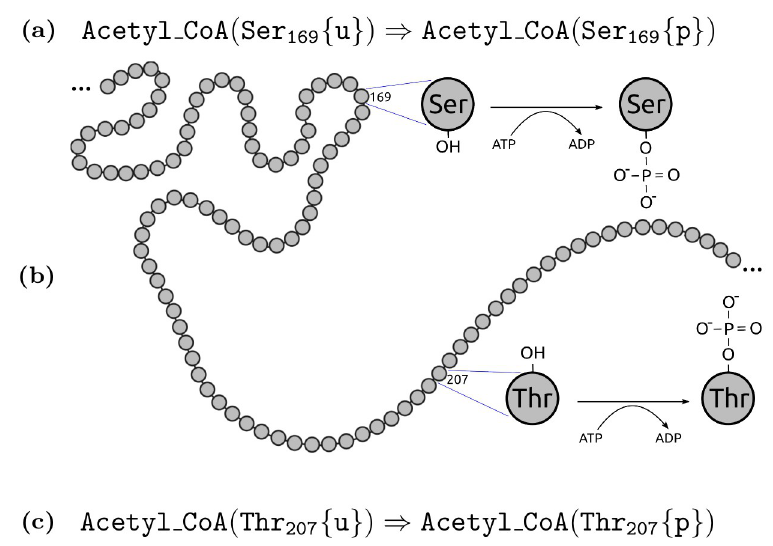
Fig 2. (B) A schematic description of a part of primary of Acetyl-CoA carboxylase (UniProt :: O00763). Two amino acid residues of modelling interest are highlighed—a serine on position 169 and a threonine on position 207—where both of them can be modified by an independent phosphorylation process. (A) (resp. (C)) The rule-based abstraction allows to write a rule which focuses purely on the particular phosphorylation of serine (resp. threonine)